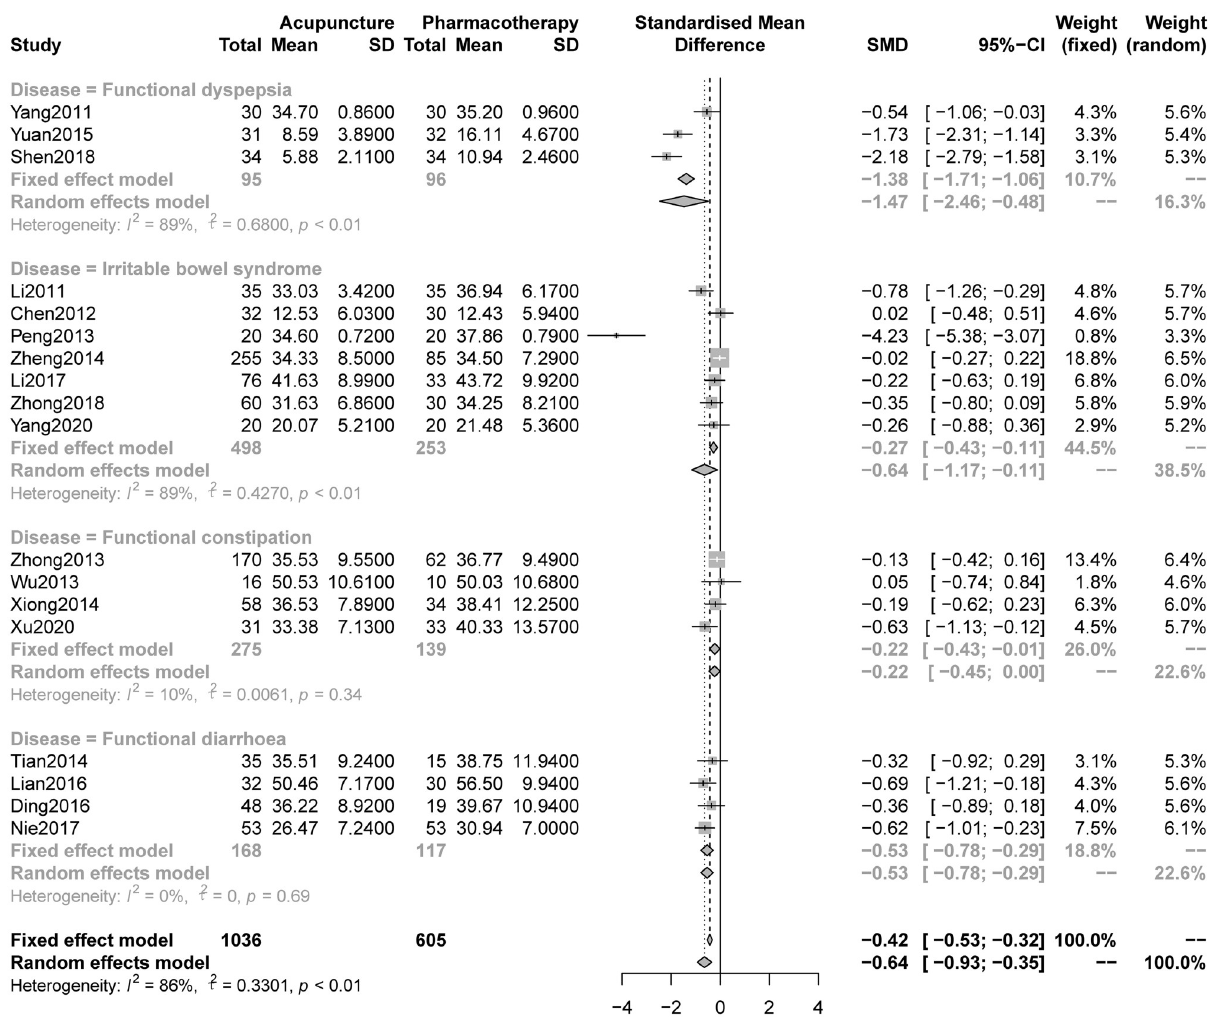
Fig 3. Forest plot of comparison: Acupuncture versus pharmacotherapy, outcome: Severity of anxiety at the end of treatment.